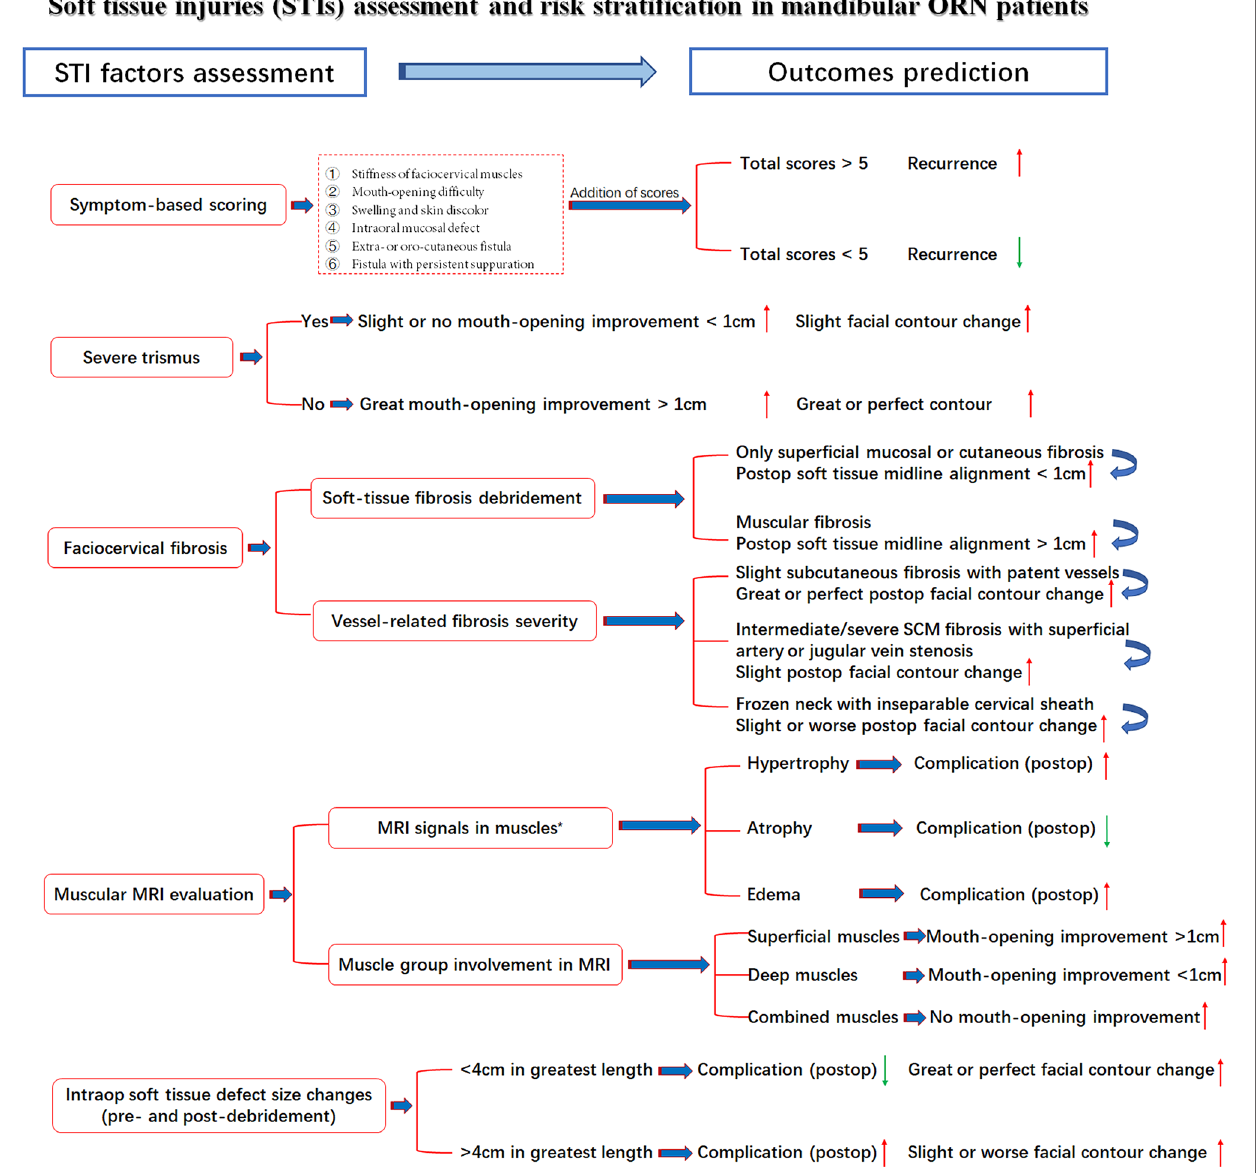
FIGURE 5 | STI assessment with seven related factors, risk strati fi cations and outcome prediction. Red arrow: Higher/increased probability of outcomes; Green arrow, Lower/decreased probability of outcomes; *, Observed tendency despite insigni fi cant